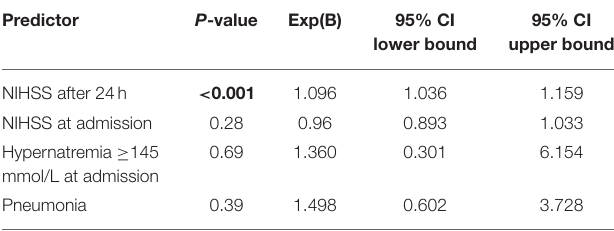
TABLE 2 | Multiple logistic regression analysis showing the influence of different variables on seizure risk. Predictor P -value Exp(B) 95% CI